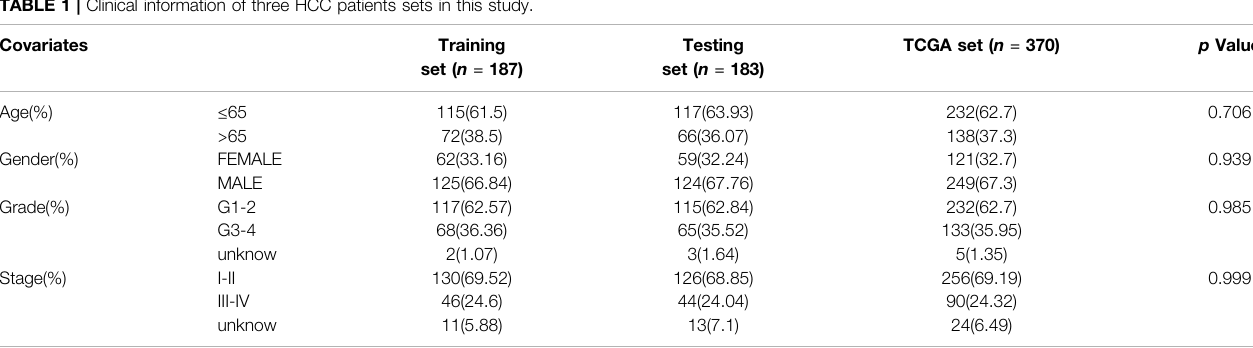
TABLE 1 | Clinical information of three HCC patients sets in this